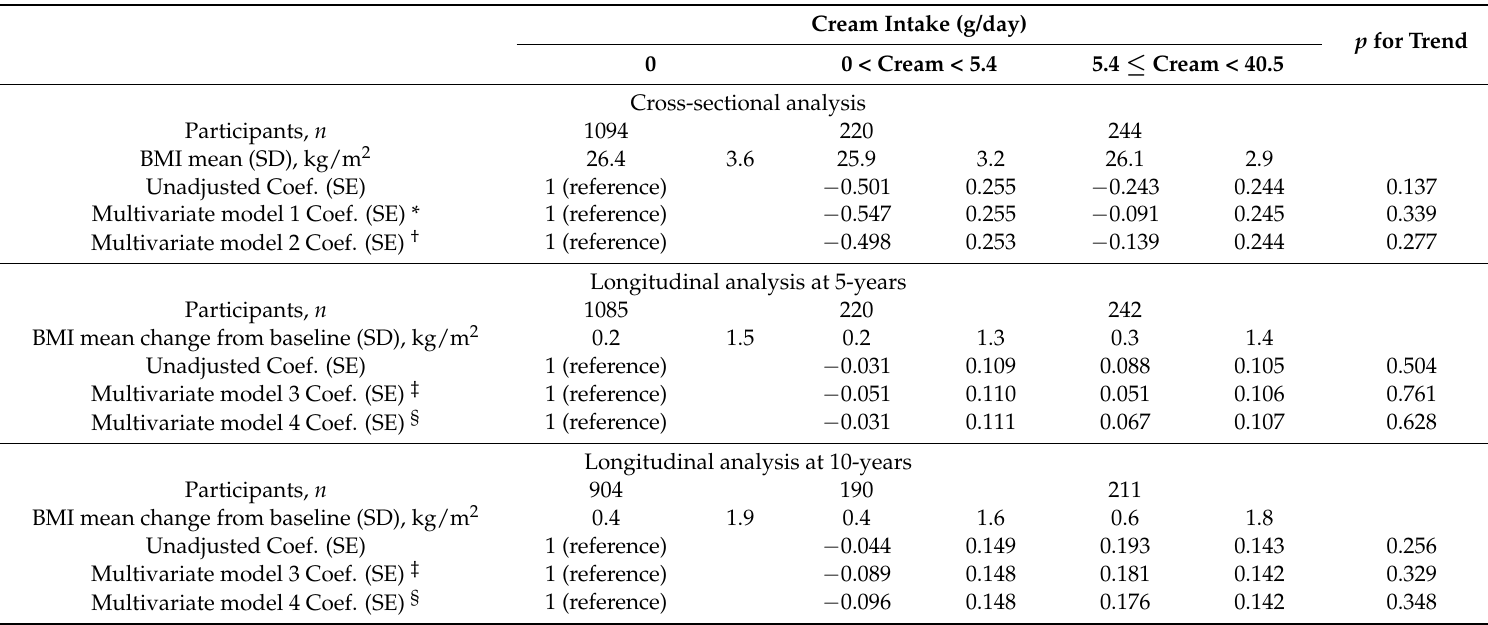
Table 5. Cross-sectional analysis of BMI at baseline and longitudinal analyses over 10-year of BMI changes from baseline by tertile of cream intake.